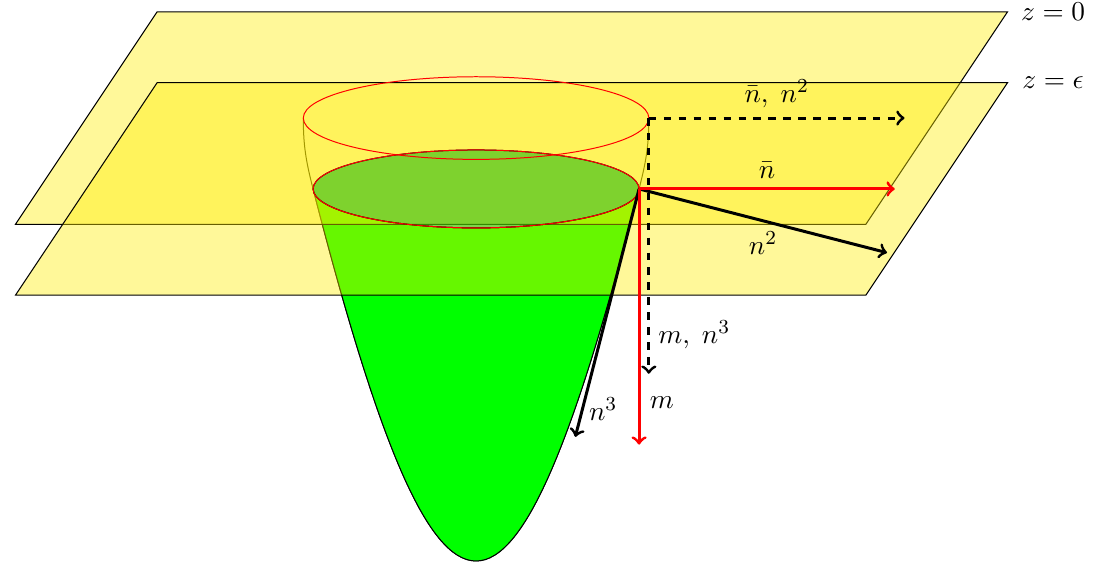
Figure 1 . In this diagram the temporal direction, n 1 , is suppressed. We can identify two distinct sets of normal directions: n 2 is the normal of the Σ and n 3 is the normal of ∂ Σ within Σ , while ¯ n is the normal of ∂ Σ on ∂M and m is the normal of ∂M in M . On the regulated boundary ∂M | z = (cid:15) , n 2 and n 3 are not equal to ¯ n and m respectively. However the normal space is manifestly spanned by both { n s , s = 1 , 2 , 3 } and { n 1 , ¯ n, m }